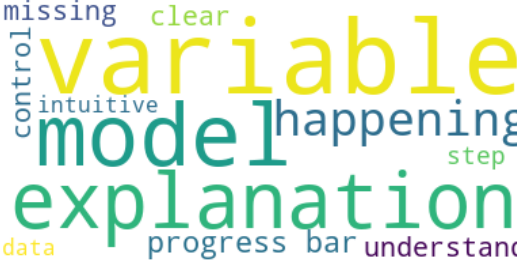
Figure 4. Word cloud of all comments on artefact evaluation questions.